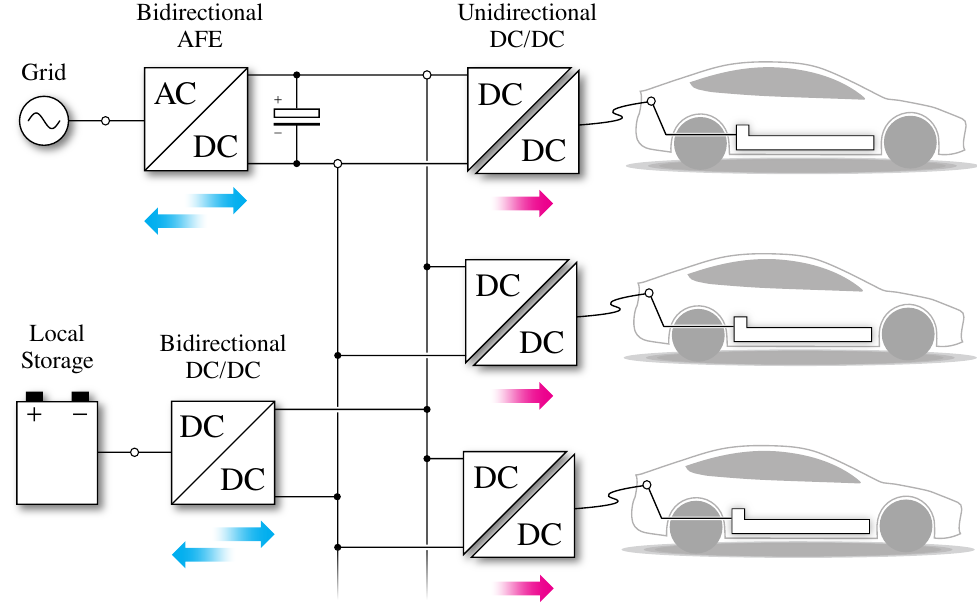
Figure 5. Simplified schematic of a next-generation bidirectional EV fast-charging station with integrated energy storage and distributed